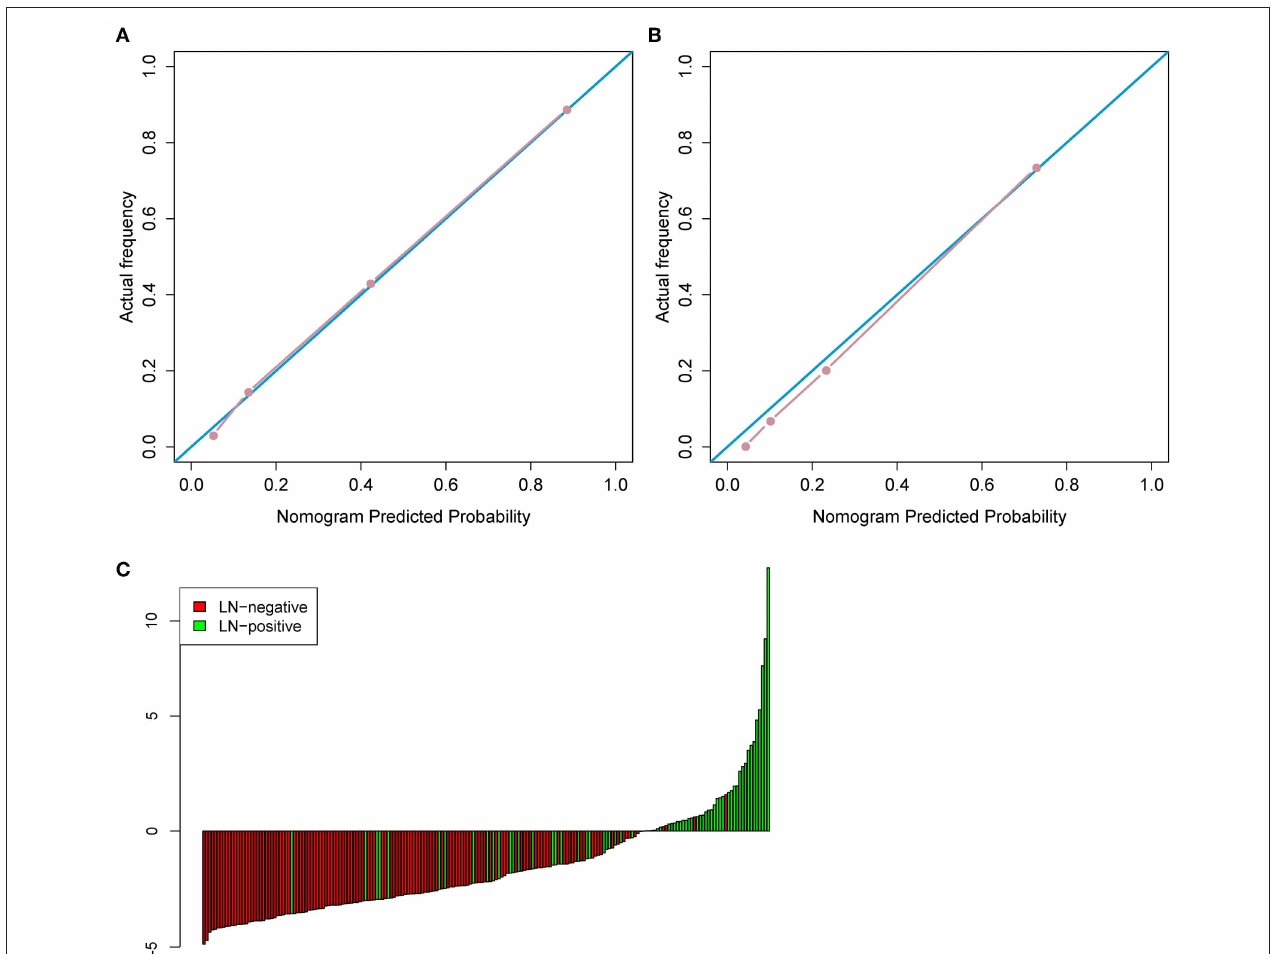
FIGURE 5 | (A) The calibration curve in the training cohort. (B) The calibration curve in the test cohort. (C) Patient risk score output by Model CR1 , while red bars show scores for those who were pathologically